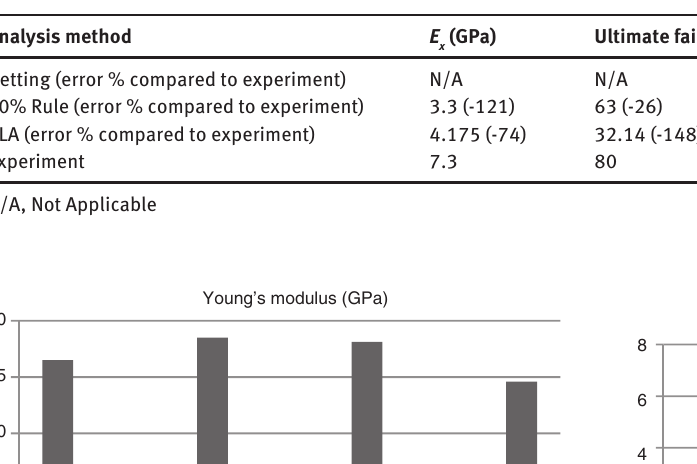
, -67.5 ] specimen tensile 4 4 s